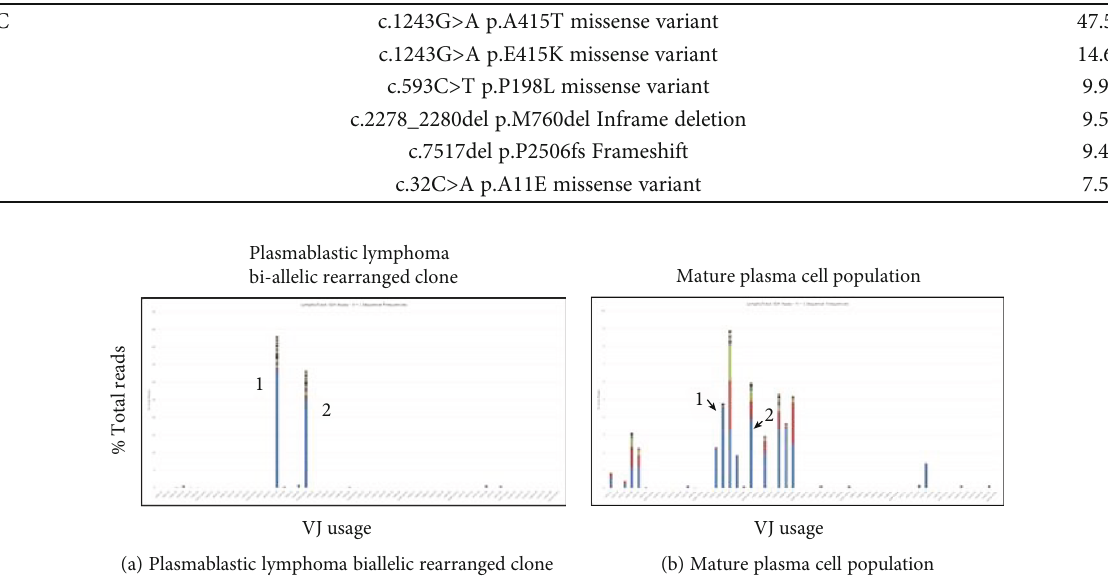
Figure 5: Immunoglobulin heavy chain clonality testing by next-generation sequencing. (a) Results from the plasmablastic lymphoma demonstrating two distinct peaks consistent with a biallelic rearranged clone. (b) Results from the mature plasma cell neoplasm with inclusive results due to a low number of reads, but demonstrating an oligoclonal pattern with low-level detection of the biallelic clone found in the PBL